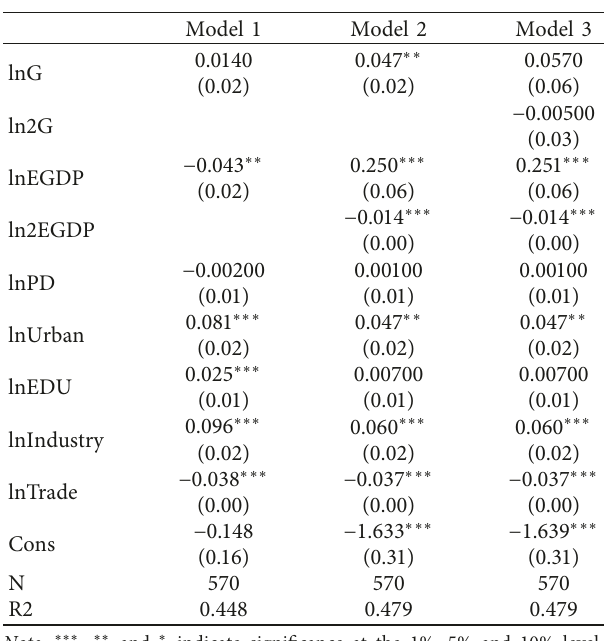
Table 5: Basic results. Table 4: KMO and SMC of each gas pollutant